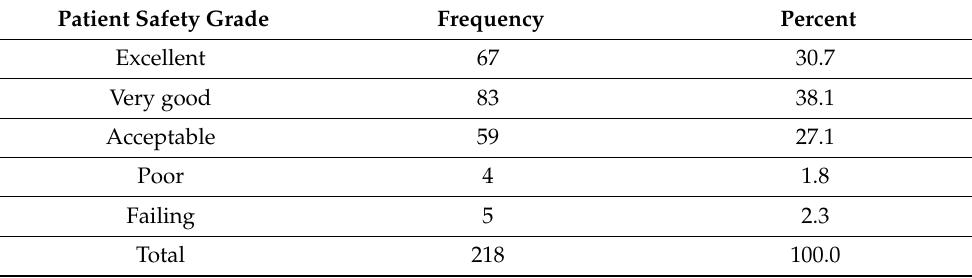
Table 2. Patient safety grade.